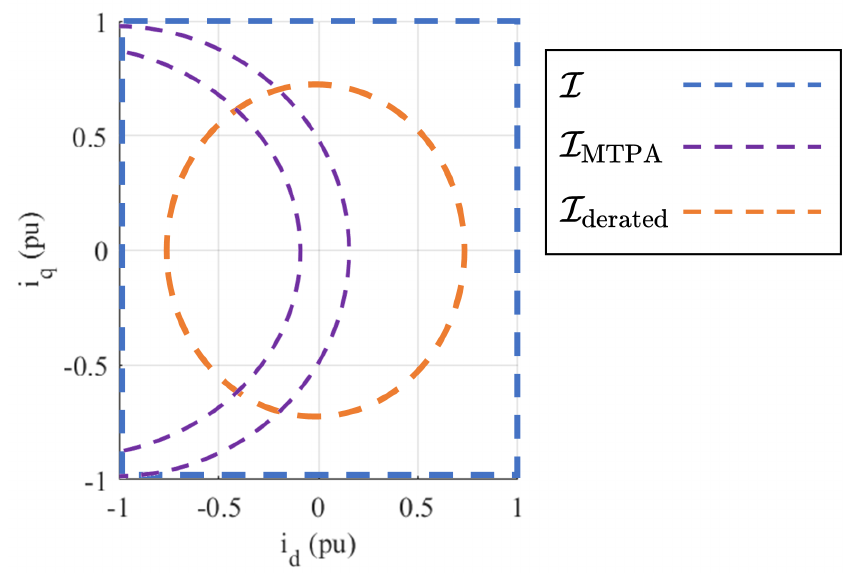
Figure 10. Visualization of three regions of current to optimize f PWA : I , I MTPA , and I derated